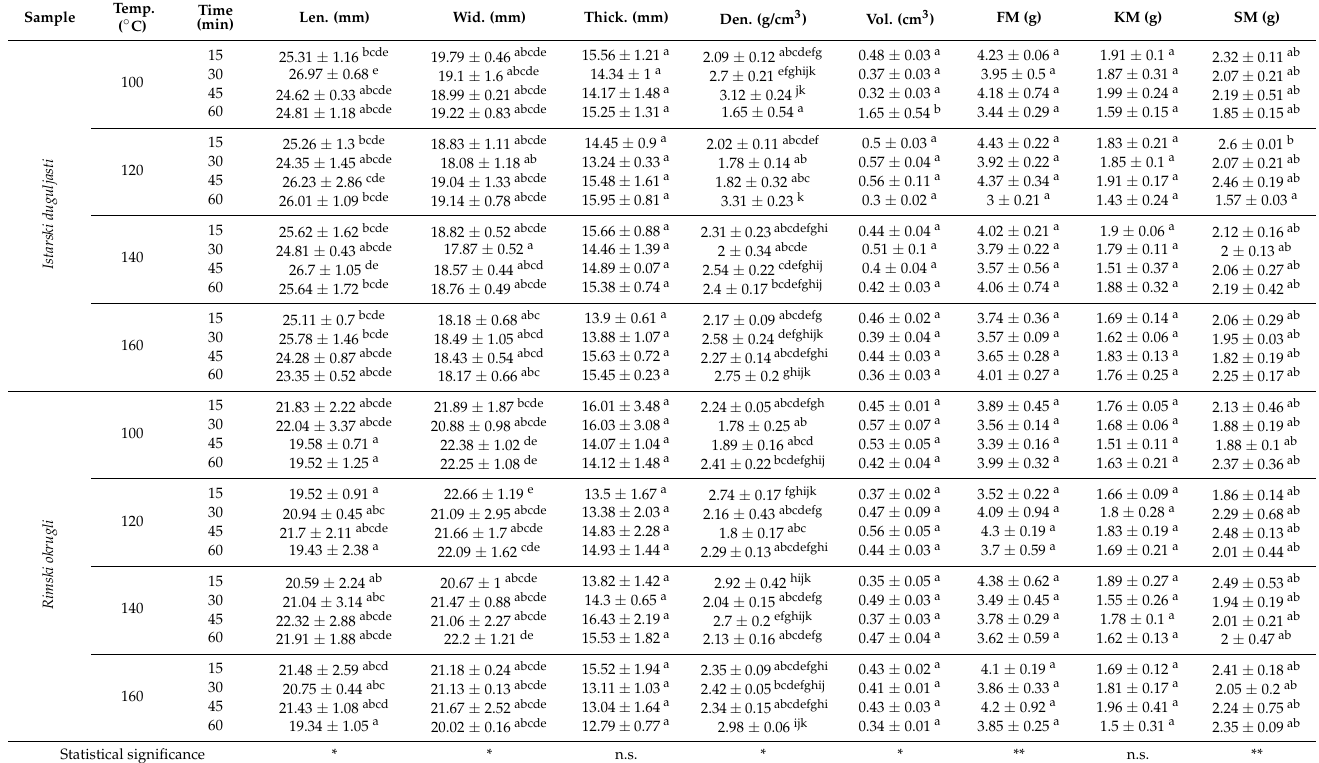
Table 3. Physical properties of observed hazelnut varieties after drying